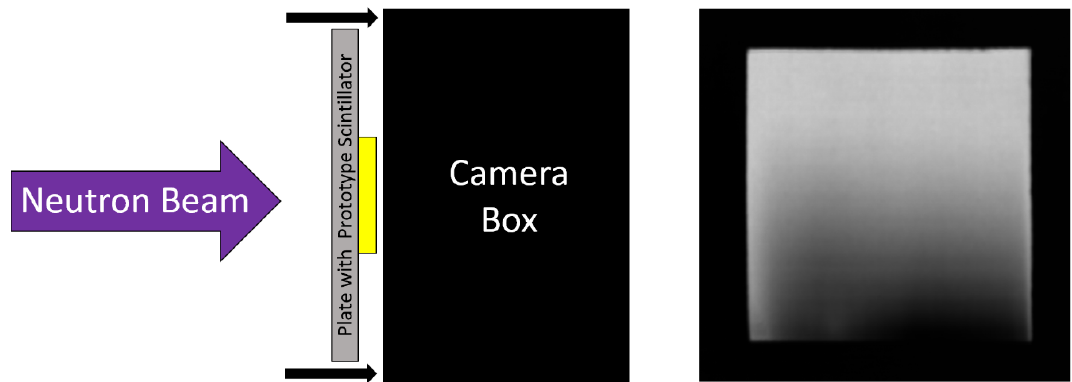
Figure 3. ( Left ) Diagram of a light yield measurement. The test-screen is optically coupled directly to the camera. ( Right ) A neutron radiograph acquired with a 6 LiF:ZnS wedge-type scintillator screen. Non-linearity of the wedge is visible in the radiograph which is accounted for using the method described in this work.